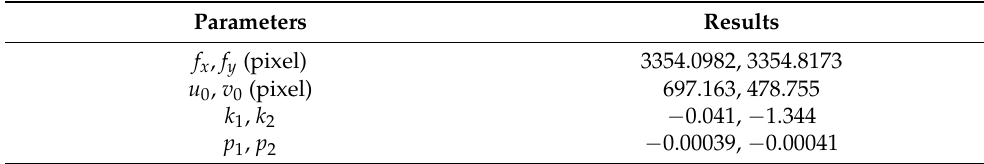
Table 2. The intrinsic parameters and distortion coefficients.